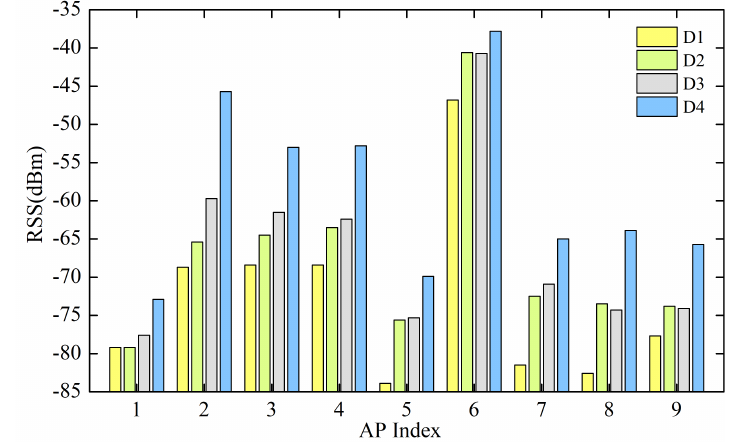
Figure 3. RSS values measured by different equipment at the same